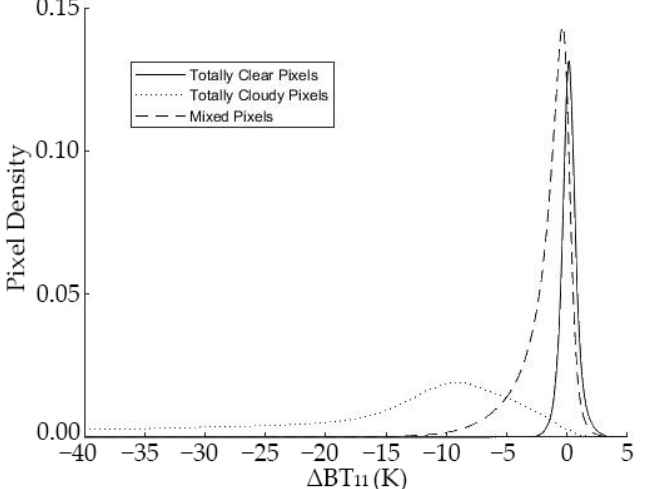
Figure 2. Probability density functions for clear, covered, and partially covered conditions. Midlati- tude